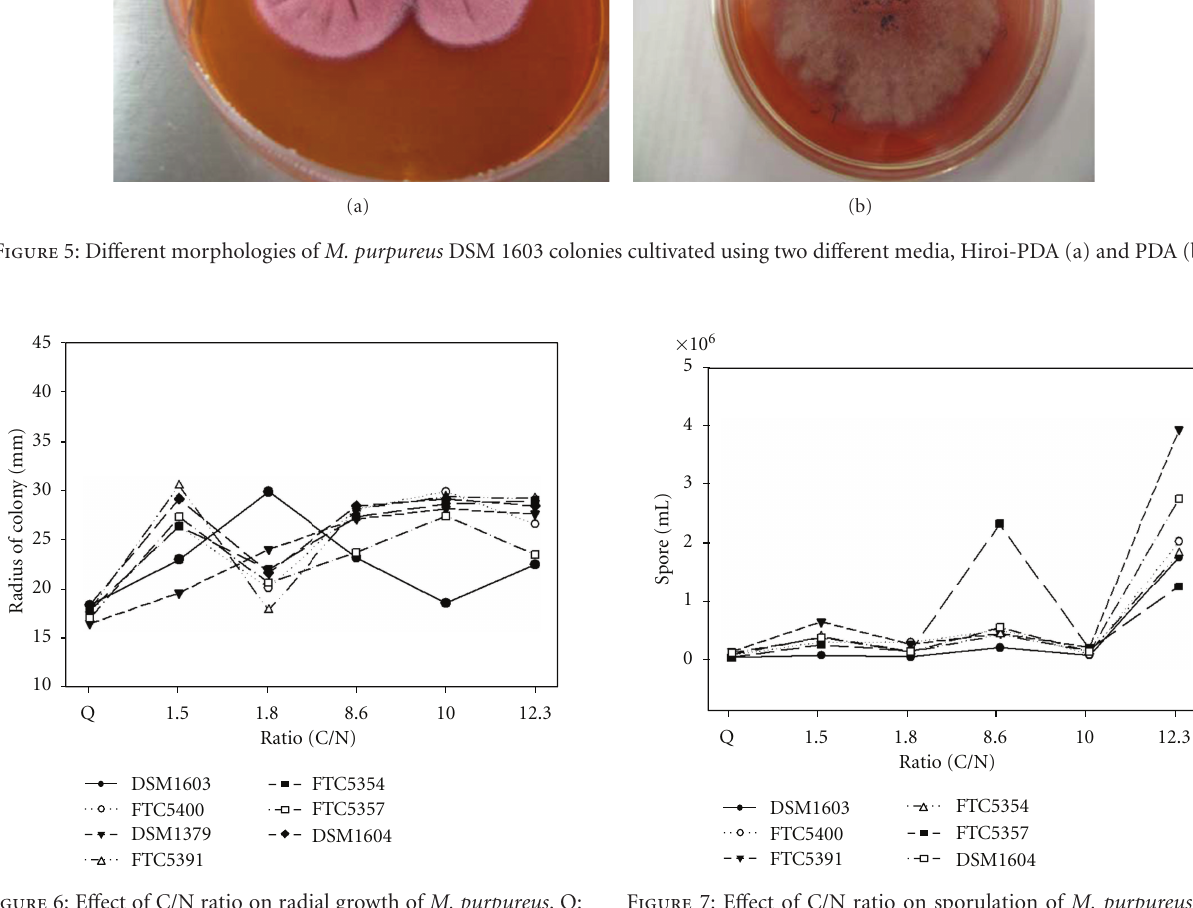
Figure 6: E ff ect of C/N ratio on radial growth of M. purpureus . Q: C/N ratio of PDA (potato dextrose agar) medium (PDA does not include nitrogen source), 1.5: C/N ratio of MEA (malt extract agar), 1.8: C/N ratio of IM (improved medium), 8.6: C/N ratio of Hiroi, 10: the C/N ratio of PM (power medium), and 12.3: C/N ratio of Hiroi-PDA.